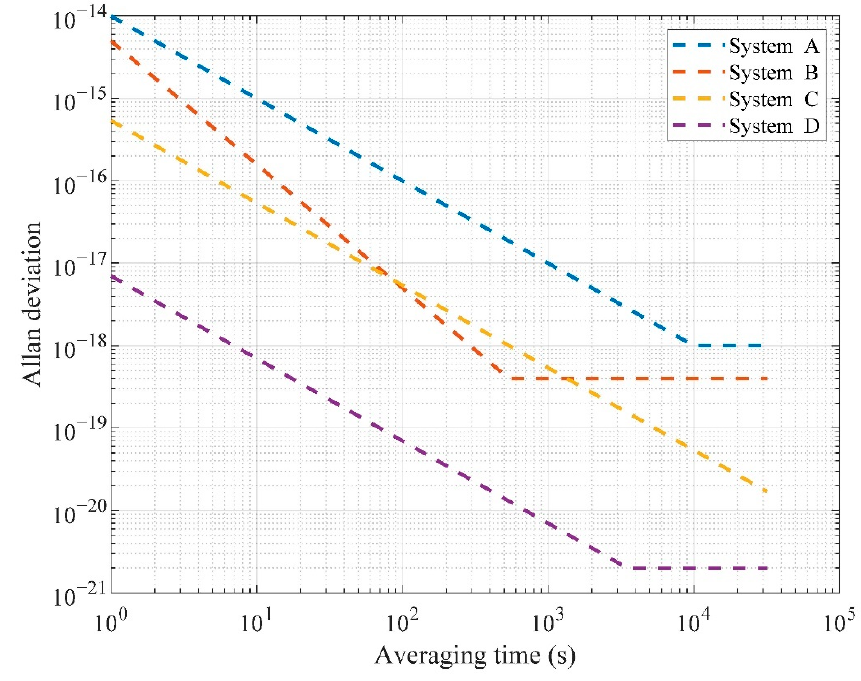
Figure 6. Accuracy of different OFFT systems.